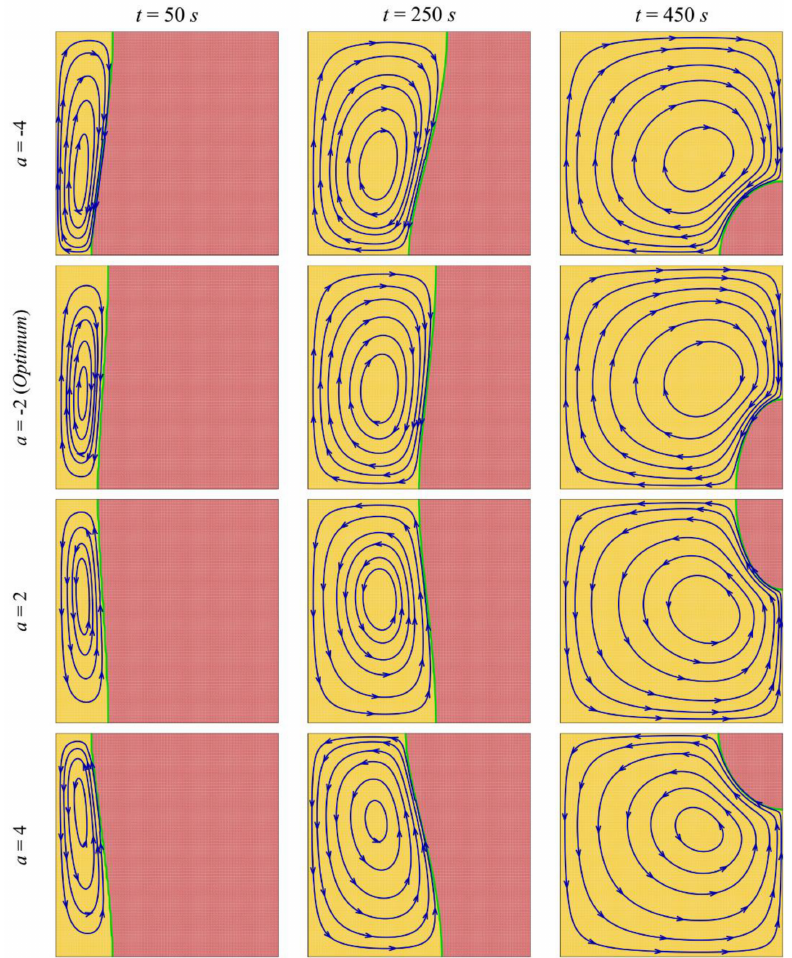
Figure 8. Stream lines and melting interface (green solid line) at three different times for various porosity parameters ( a ) when VF na = 0.01, ε = 0.800, γ = 2 π /4, and PPI =